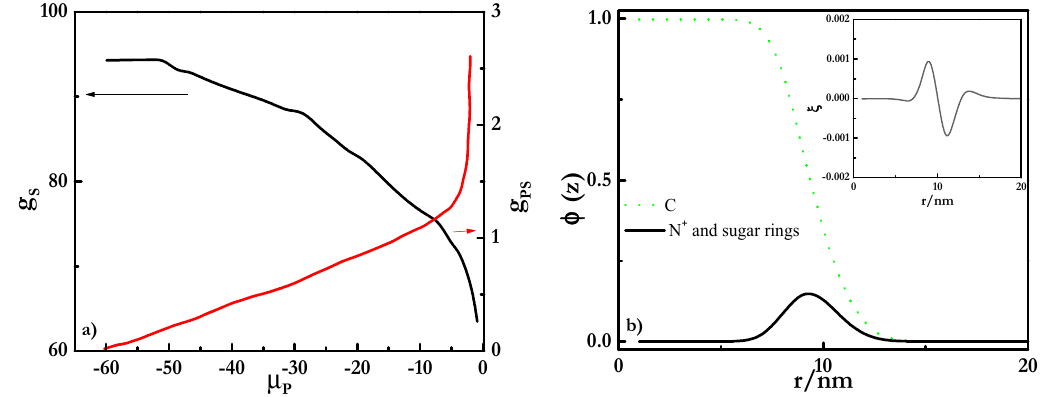
Figure 9. Radial volume fraction, φ ( z ), profiles for the inner hydrophobic core and the charged corona of PDADMAC-di-RL complexes. The polyelectrolyte had a length of 100 segments and a segment valence ν p = 1. The inset represents the dimensionless radial charge density ( ξ ) profiles for the complexes.